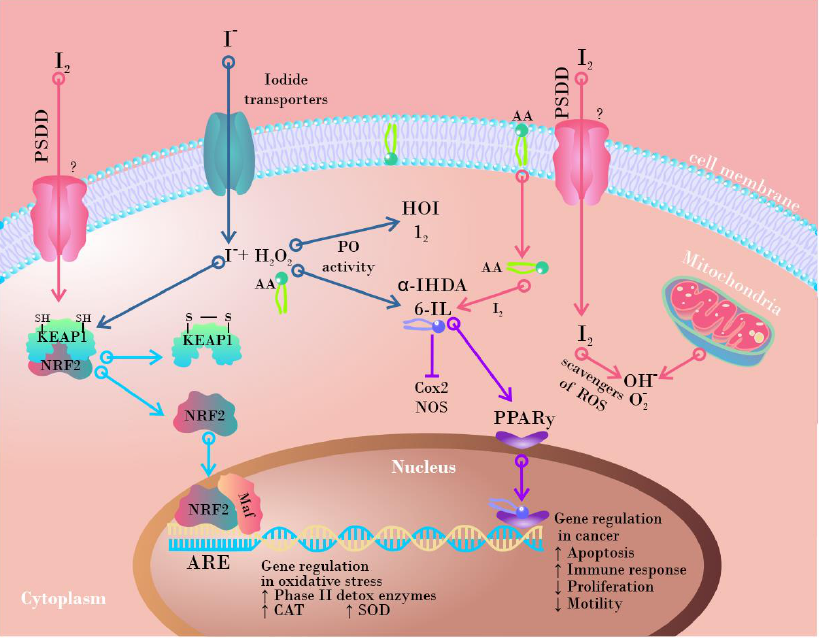
Figure 6. Molecular events influenced by iodine in mammal cells. To face the oxidative stress caused by ROS, some of the proposed molecular mechanisms of iodine are as follows: (1) using I − as a cofactor in PO reactions (yielding I 2 , HIO, α -IHDA, or 6-IL); (2) as a direct scavenger of ROS produced by mitochondria (OH • radical and O 2 − ) by I 2 (yielding HIO and HI); (3) activation of the Nrf2 – ARE pathway; (4) inhibition of pro-oxidant and proinflammatory enzymes NOS and Cox2 by 6-IL (adapted from [166], MDPI, 2016). Abbreviations: I − , iodide; I 2 , molecular iodine; 6-IL, δ -lactone; AA, arachidonic acid; ARE, antioxidant response element; CAT, catalase; Cox2, cyclooxygenase type 2; Keap1, Kelch-like ECH-associated protein 1; NOS, nitric oxide synthase; Nrf2, nuclear factor erythroid 2-related factor 2; O 2- , superoxides; OH • , hydroxyl radical; PO, peroxidases; PPARγ , peroxisome proliferator-activated receptor type gamma; PSDD, protein synthesis-dependent diffusion; SOD, superoxide dismutase.